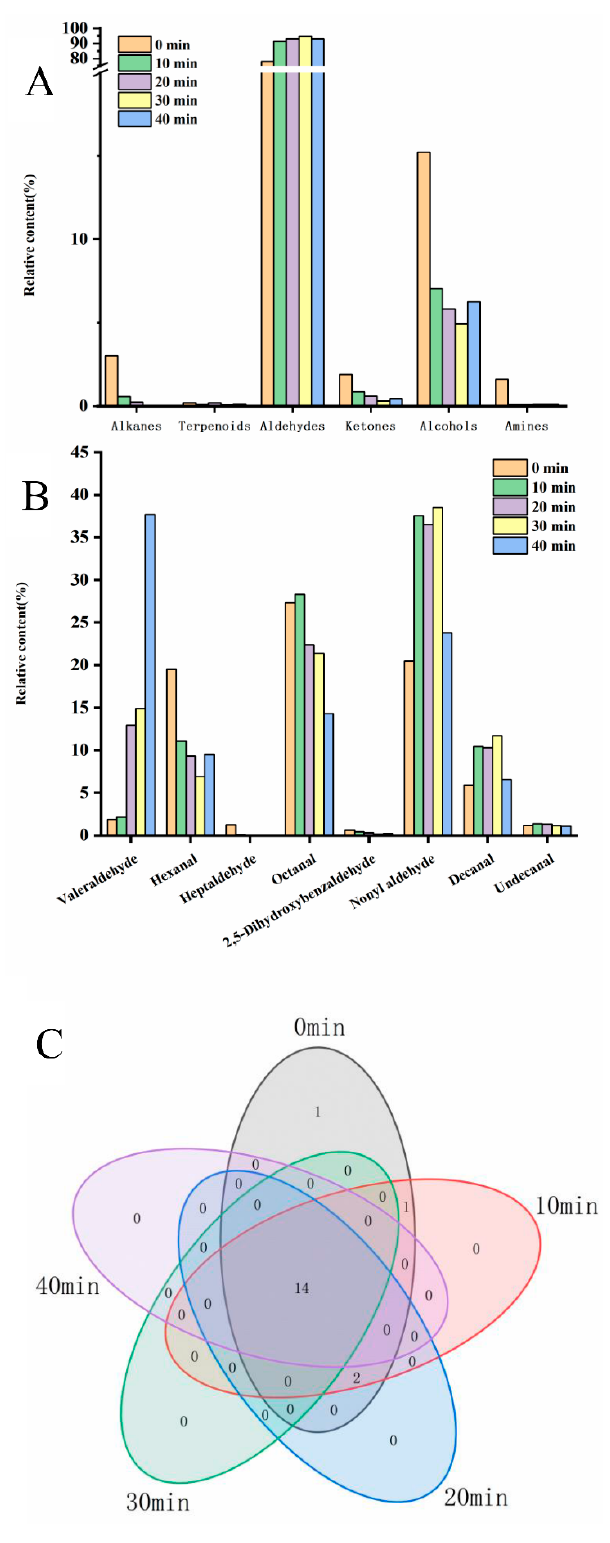
Figure 2. Composition of egg yolk volatile fraction species under different ozone treatment times. ( A ) Total volatiles; ( B ) aldehyde volatiles; ( C ) Wayne